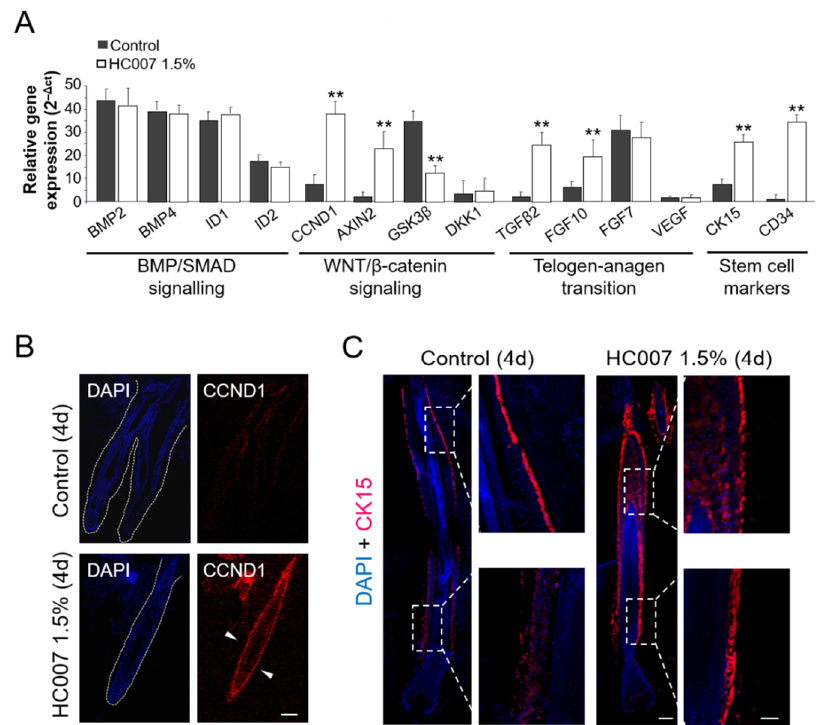
Figure 2. Activation of WNT/ β -catenin signaling and of stem cell niche proliferation in human hair follicle growth ex vivo in a defined glycosaminoglycan hydrogel matrix (HC007). ( A ) Quantitative expression analysis by qRT-PCR analysis of selected genes. Input mRNA was obtained from three or four hair follicles per experimental condition, namely, control and HC007 1.5% samples, and the mean +/- SD of relative gene expression values, normalized to 18S rRNA, is represented. **, significant p ≤ 0.1. ( B , C ) Confocal microscopy images (maximum projections) of the immunolocalization of the ( B ) transcriptional target of WNT signaling CCDN1 (in red; white dotted lines delineate individual hair follicles; withe arrowheads indicate positive cells in the outer root sheath) and of the ( C ) CK15 stem cell marker (white dotted boxes are enlarged in right panels) in histological sections of human hair follicles grown ex vivo four days after HC007 1.5% treatments. DAPI was used as chromatin counterstain. Results shown in ( B , C ) are representative of at least 10 hair follicles in three independent experiments. Bars: 100 µm.